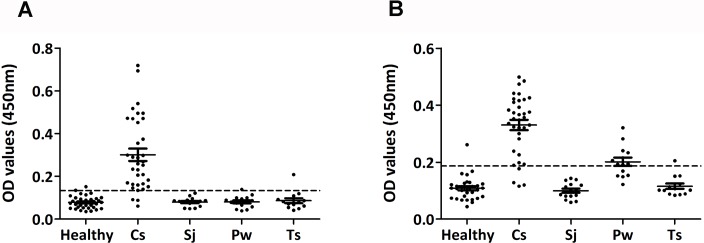
Comparison of the sensitivity and specificity of rCs1-ELISA and ESP-ELISA.(A) rCs1-ELISA. (B) ESP-ELISA. The two methods were used to assay a total of 114 serum samples, including 35 samples infected with clonorchiasis (Cs) and 36 uninfected samples (Healthy), 15 samples infected with schistosomiasis japonica (Sj), 15 samples infected with paragonimiasis westermani (Pw) and 13 samples infected with cysticercosis (Ts). OD = optical density.